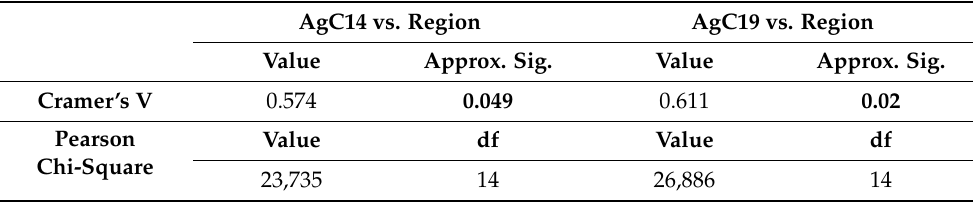
Table 7. Correlation analysis between territorial location and the categories of the composite